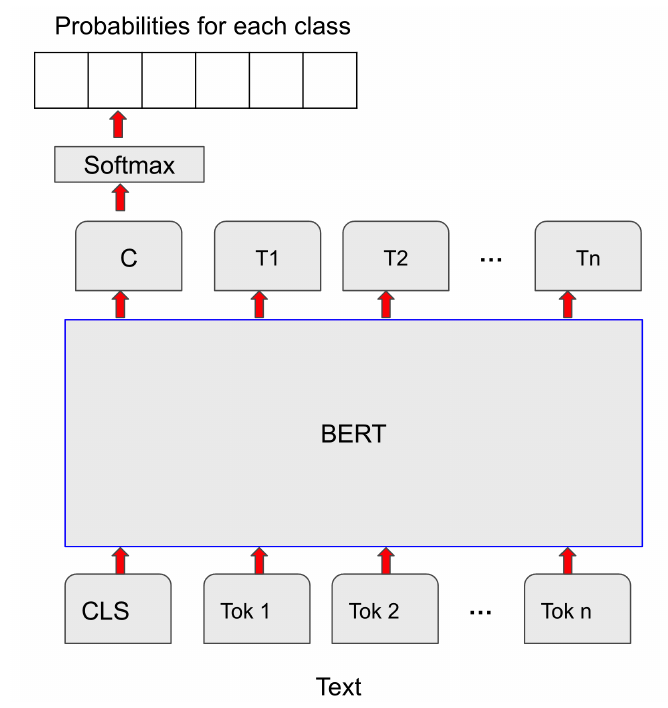
Figure 2. BERT for text